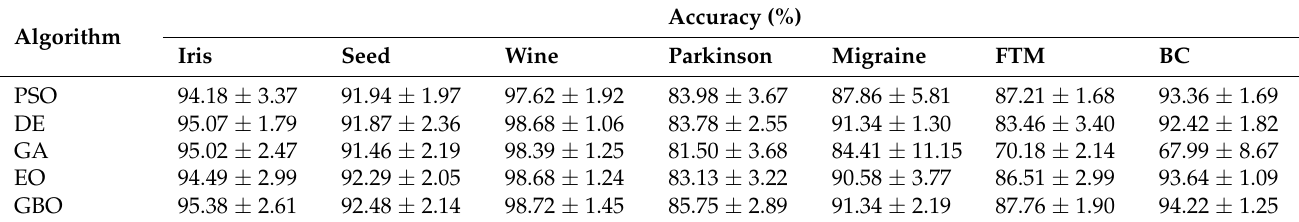
Table 3. Classification results of the five heuristic algorithms on the seven datasets.